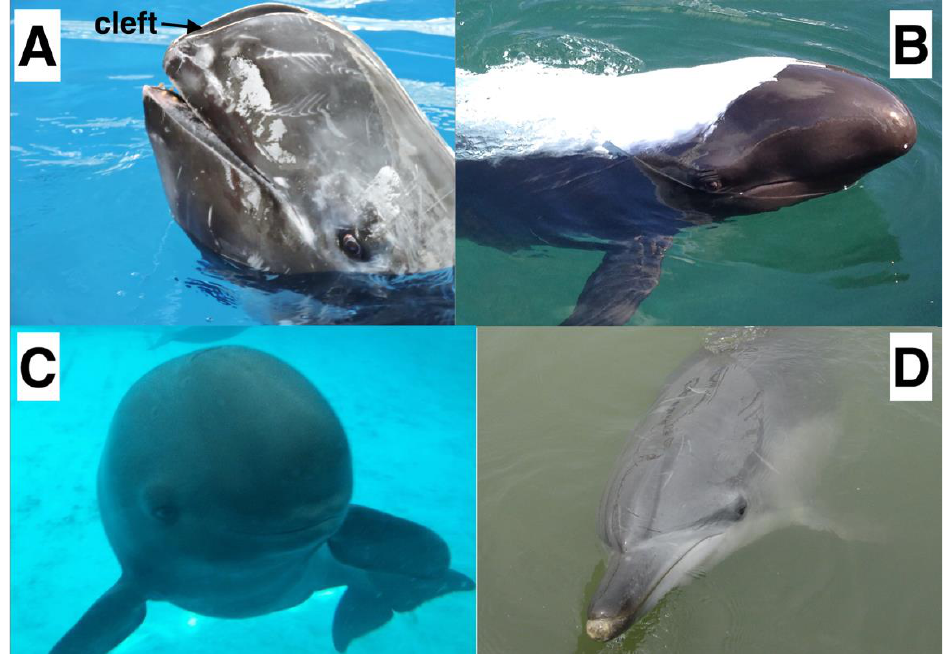
Figure 1. Comparison of the forehead shape between four odontocete species. ( A ) Risso’s dolphin, ( B ) false killer whale ( Pseudorca crassidens ), ( C ) Yangtze finless porpoise ( Neophocaena asiaeorientalis ), ( D ) Atlantic bottlenose dolphin.